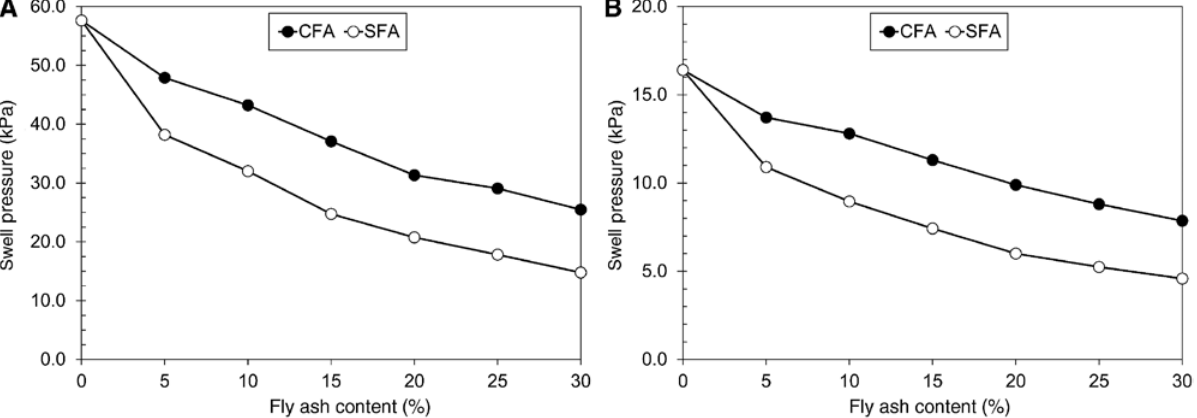
Figure 10: Effect of fly ash on swell pressure (A) Soil A-fly ash mixtures and (B) Soil B-fly ash